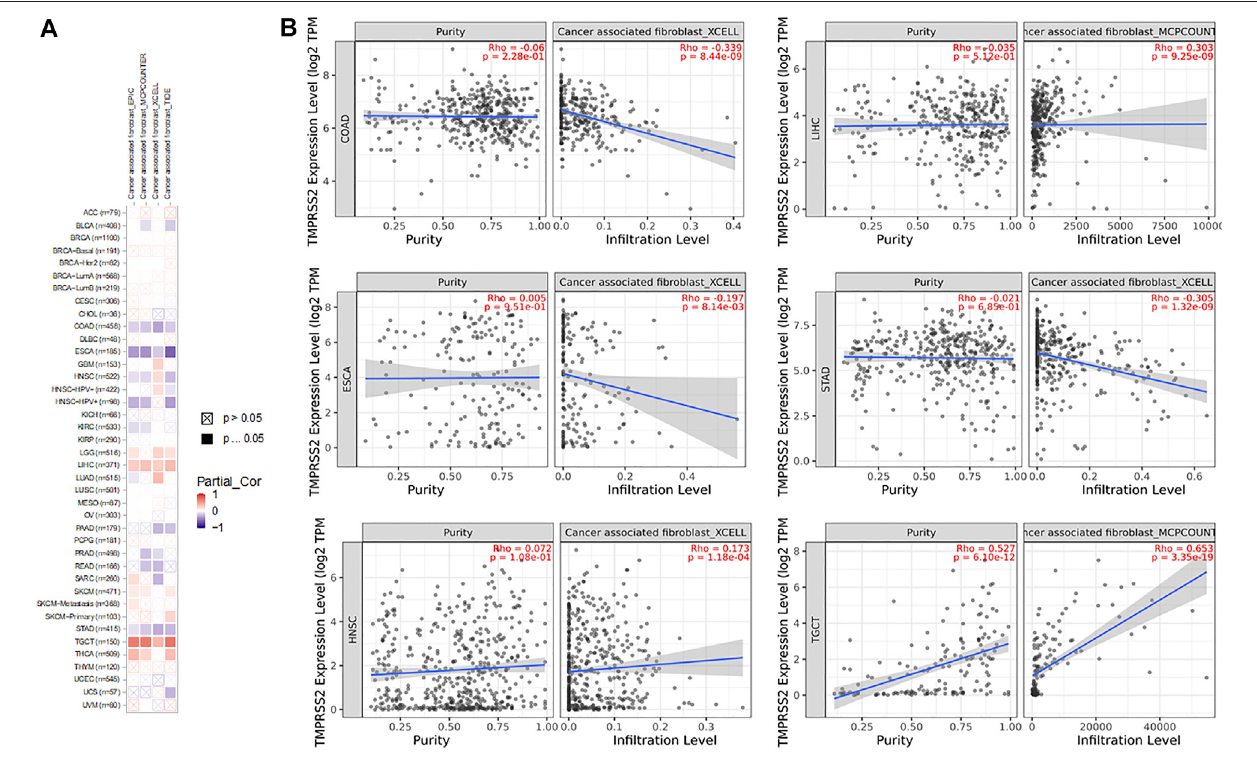
FIGURE 12 | Correlation analysis of TMPRSS2 expression and immune in fi ltration of cancer-related fi broblasts. (A) Different algorithms were used to explore the potential correlation between the expression level of the TMPRSS2 gene and the in fi ltration level of cancer-related fi broblasts in all types of cancers in TCGA. (B) Enumerated XCELL in fi ltration of COPD, ESCA, HNSC, and STAD and MCPCOUNTER in fi ltration of LIHC and